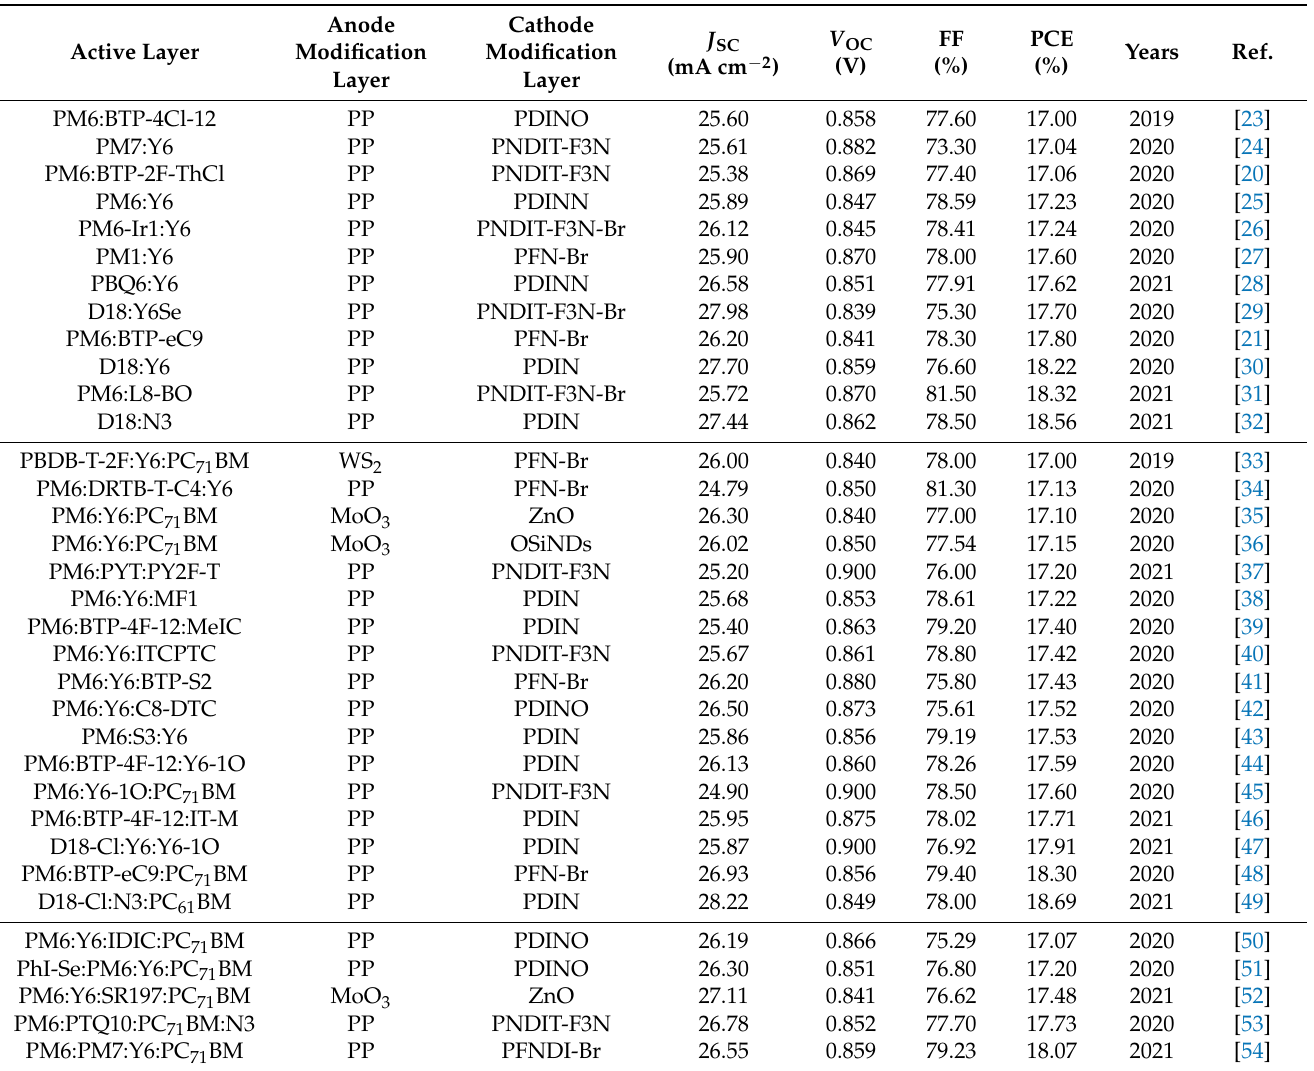
Table 1. The recent progress of OPVs with efficiency over than